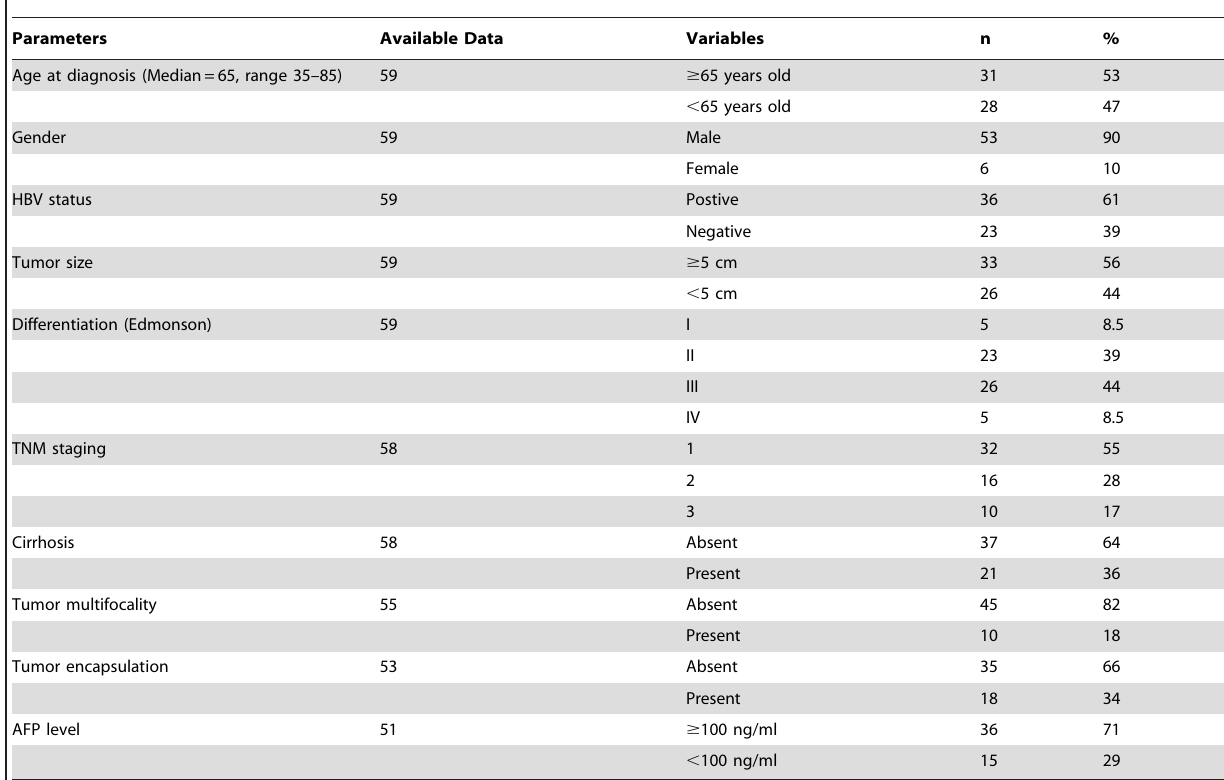
Table 1. Clinicopathological data for 59 HCC